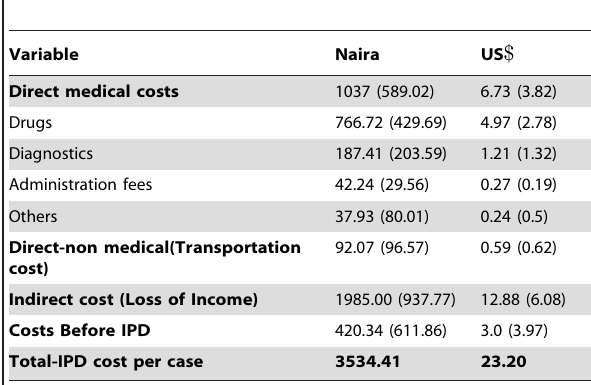
Table 3. In Patient Department (IPD)